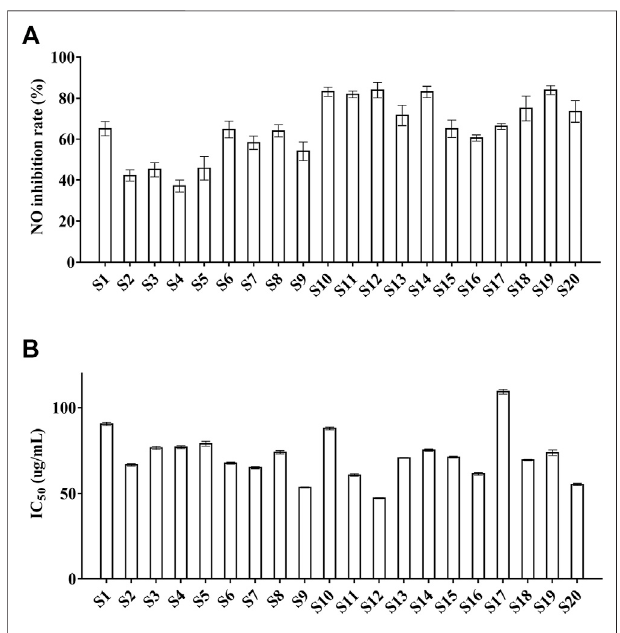
FIGURE5| TheNOinhibitionandtheantioxidantactivitiesof20batches of ZN samples. (A) NO inhibition; (B) DPPH. Values represent means ± SD, n = 5 (A) ; n = 3 (B)